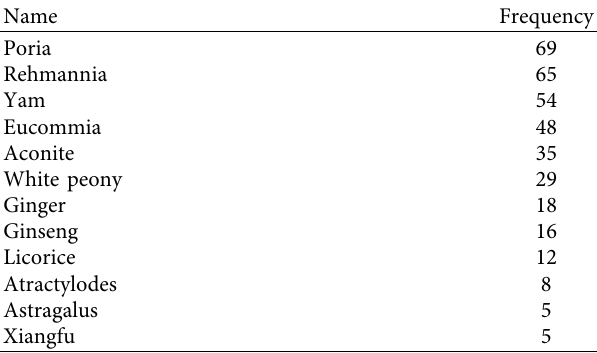
Figure 6: The comparison result of the association rule algorithm based on the network model and other algorithms in this study. Table 2: Examples of some Chinese medicines with a frequency of ≥ 3